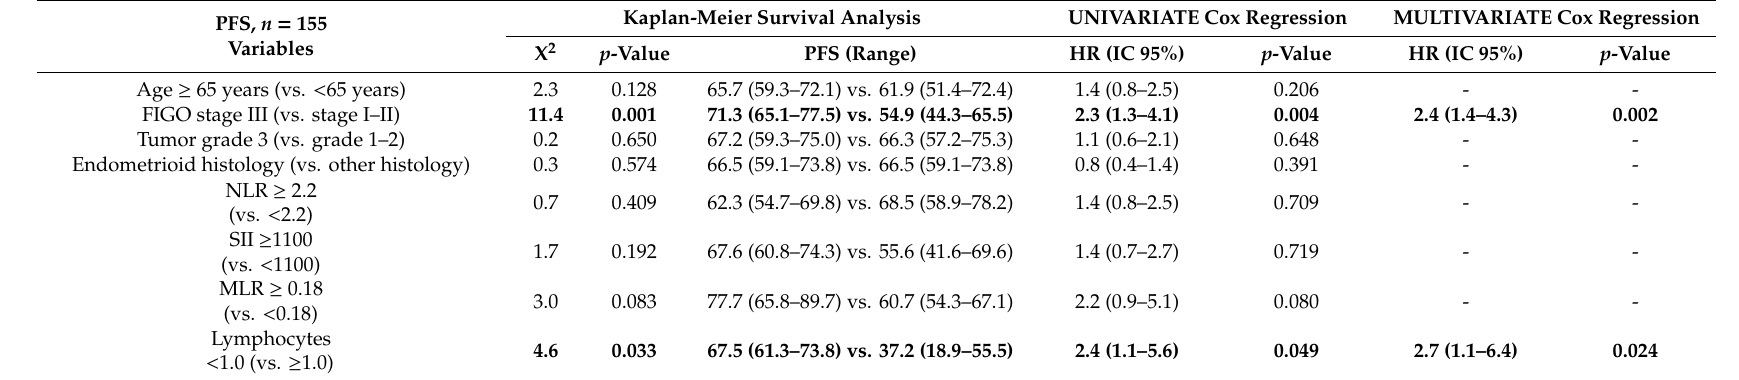
Table 3. Progression-specific survival analysis ( n =